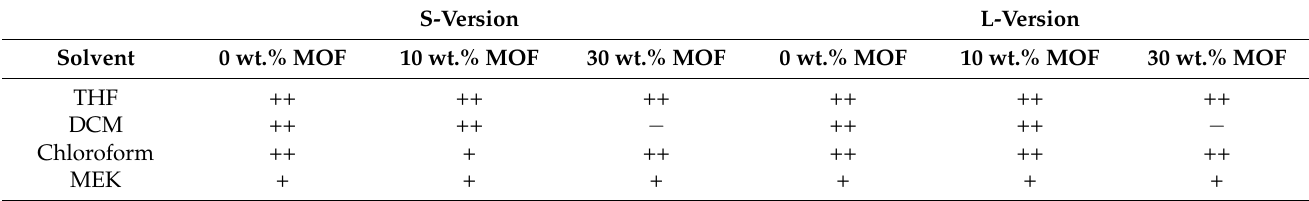
Table 3. Visual assessment of MMMs prepared with different solvents 1